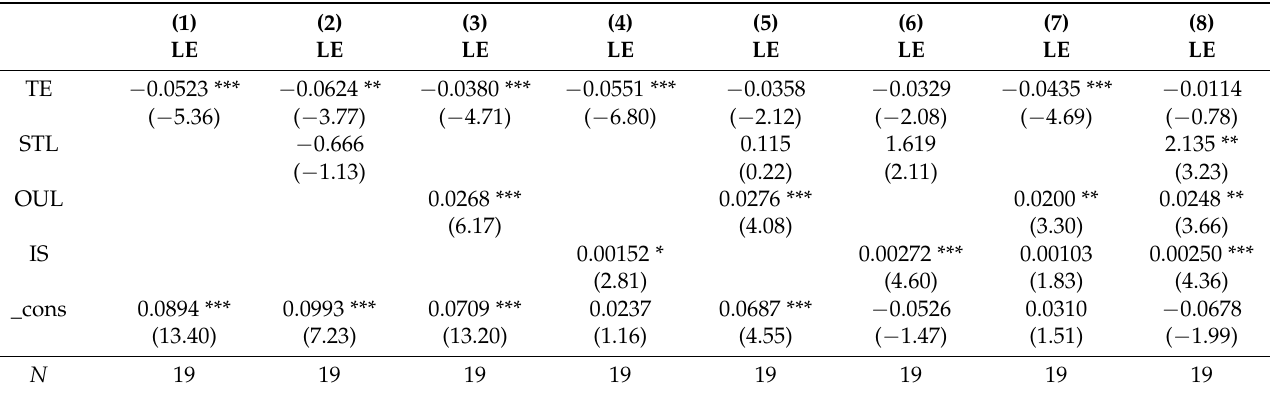
Table 12. Empirical regression